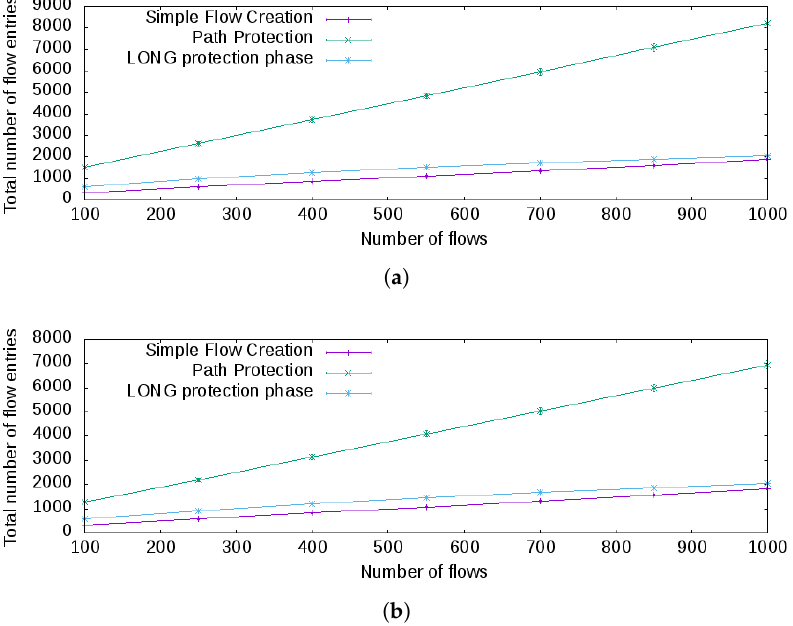
Figure 6. Number of flow entries for different topologies. ( a ) To the Abilene topology, the number of flow entries for each approach adopting 10 flows per path. ( b ) The number of flow entries for each approach with 10 flows per path using the Google